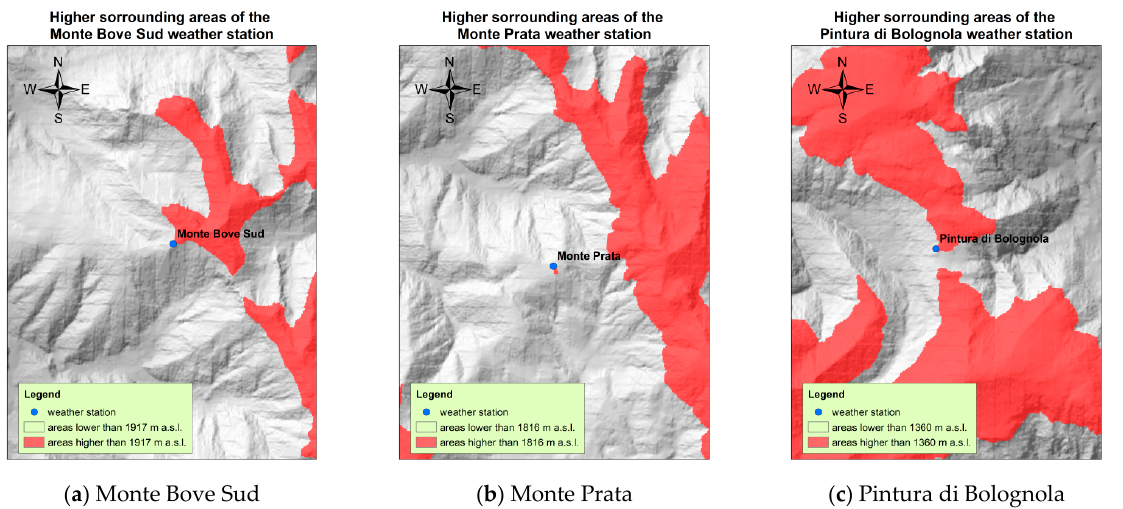
Figure 5. Map of areas with higher altitude than the weather stations analysed.